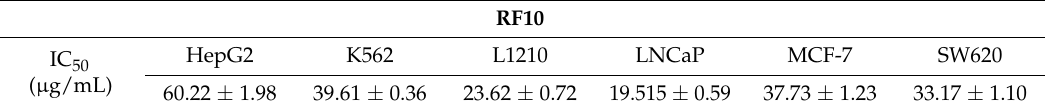
Table 1. IC 50 concentration of compound RF10 in tumor cell